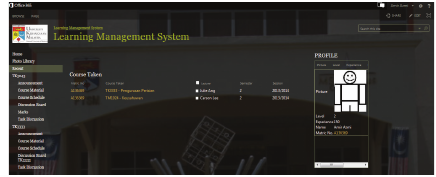
Figure 1: Screenshot of home page.